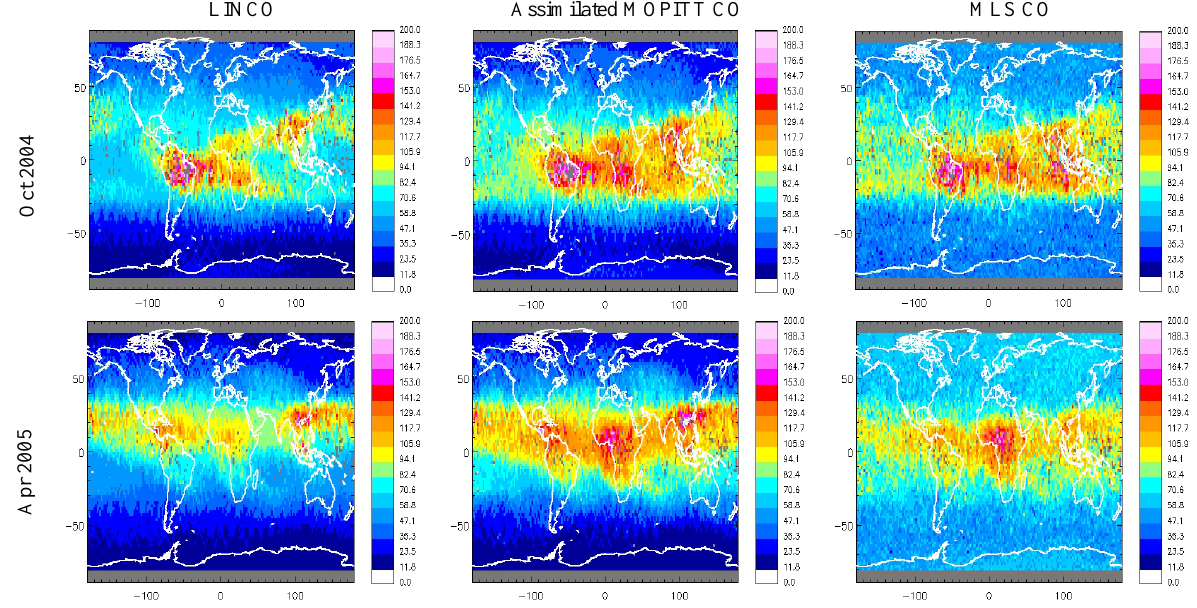
Fig. 11. CO fields calculated by LINCO (left), assimilated MOPITT CO (center) and MLS CO (right) in parts per billion by volume (ppbv) in October 2004 (upper panel) and April 2005 (lower panel) at 146hPa. Note that LINCO and assimilated MOPITT CO have been smoothed by triangular MLS averaging